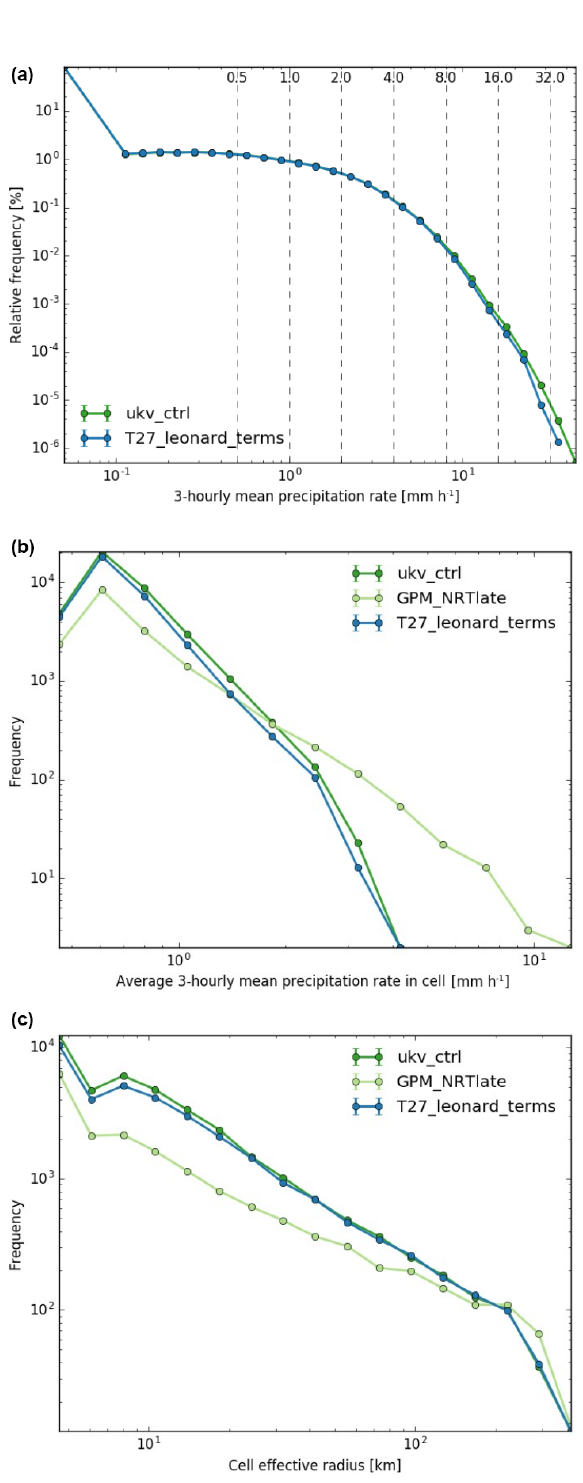
Figure 6. The 3h mean precipitation histogram (a) , cell mean value (b) and cell effective radius (c) against GPM near-real-time (NRT) late observations for UKV case studies run with the Leonard term.